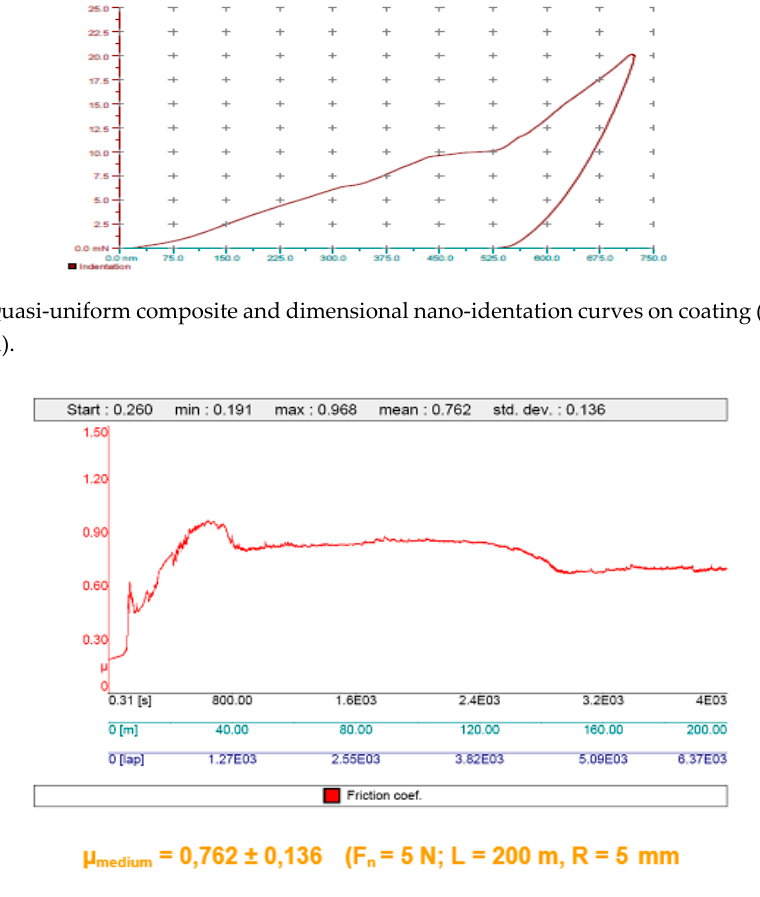
Figure 16. Values of the friction coefficient for the tribological samples test in air. (V l = 5 cm/s, and WC ball of 6 mm